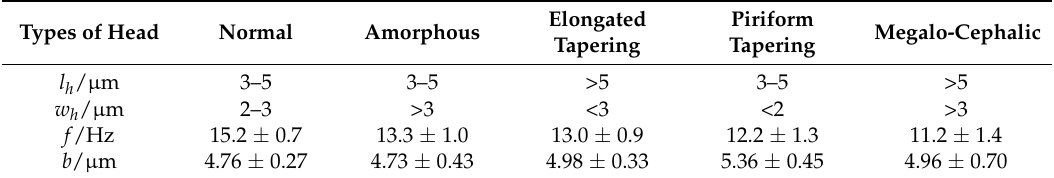
Table 1. Categories of sperm according to their head morphology, and the corresponding flagellum beat frequency and amplitude given with their respective standard deviations. Data from [32].